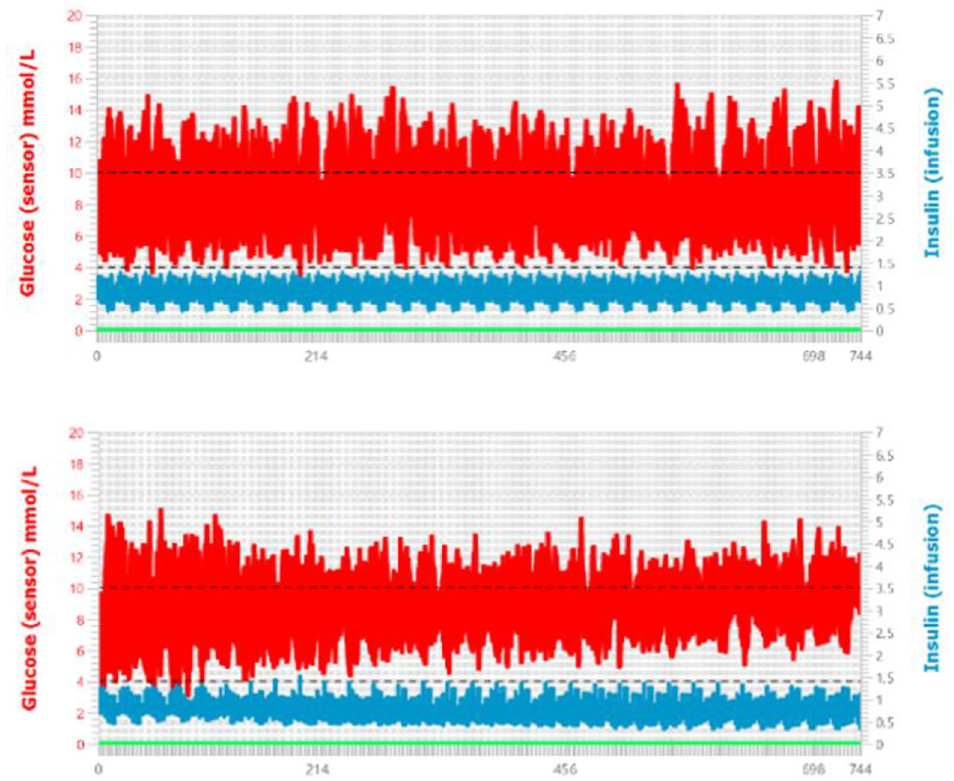
Fig 5. Comparison of Open-Loop vs. Fuzzy-Logic Learning algorithms. (Top) 31-day trial using the Open-Loop Algorithm (bottom) Fuzzy-Logic Learning Algorithm trial results. Red Lines represent the 25% and 75% IQR median range of blood glucose levels across all 15 patients, the blue lines represent insulin basal injections, and the x-axis plots clinical trial simulation time in hours.